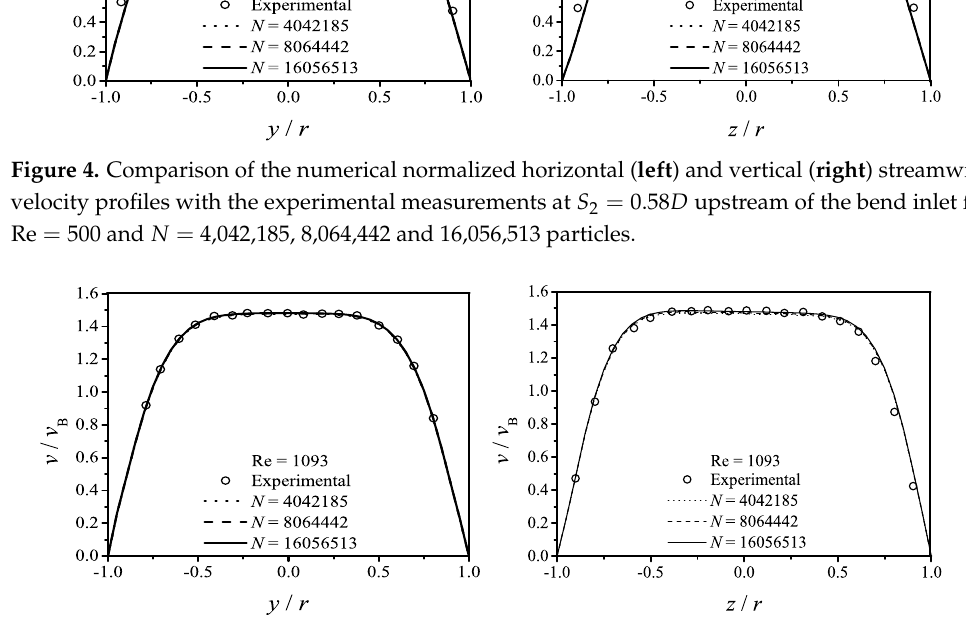
Figure 5. Comparison of the numerical normalized horizontal ( left ) and vertical ( right ) streamwise velocity profiles with the experimental measurements at S 2 = 0.58 D upstream of the bend inlet for Re = 1093 and N = 4,042,185, 8,064,442 and 16,056,513 particles. Figure 6 shows maps of the streamwise velocity for Re = 500 (left) and 1093 (right) in three cross-stream planes at θ = 30 ◦ , 60 ◦ and 75 ◦ in the bend and at S 3 = 1 D downstream of the bend outlet for the N = 16,056,513 run. Almost indistinguishable plots to Figure 6 were also obtained for N = 8,064,442 particles. The velocity maps reproduce the shape of Enayet et al.’s [1] experimental contours at the same stations and the values of v / v B associated with the colors in the maps fit very well their contour level numbers (see their Figures 4 and 6). As a result of doubling the Reynolds number, the transverse pressure gradient within the bend increases and, as a consequence, the secondary flow becomes more intense. In both cases, the secondary flow develops gradually and displaces the core region of maximum velocity to the outer arc of the bend. At the θ = 30 ◦ plane, a thickening of the shear layer towards the inner arc of the bend is already visible. This effect is greater for Re = 1093 than for Re = 500. When the flow crosses the θ = 60 ◦ plane, the secondary flow is almost fully developed in both cases, leading to a C-shaped distortion of the core and a displacement of the peak velocity from the plane of symmetry. Owing to the increased centrifugal forces and transverse pressure gradients, the secondary flow is stronger for the Re = 1093 case. At θ = 75 ◦ , the flow distortion is such that the region of maximum velocity takes a horseshoe shape, which is more clearly defined for Re = 1093 than for Re = 500 because of the more intense swirling secondary flow in the former case. At the exit of the bend, the secondary motion persists and does not show a significant decay at station S 3 = 1 D downstream of the bend outlet, as shown in Figure